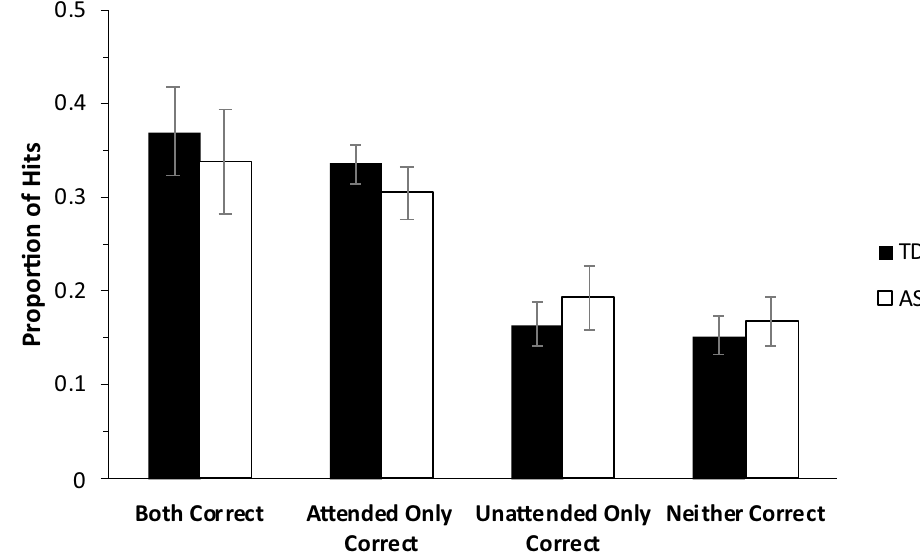
Figure 3. Proportions of hits associated with correct and incorrect judgments for both attended and unattended contexts. Note. Error bars depict 95% CI for mean.